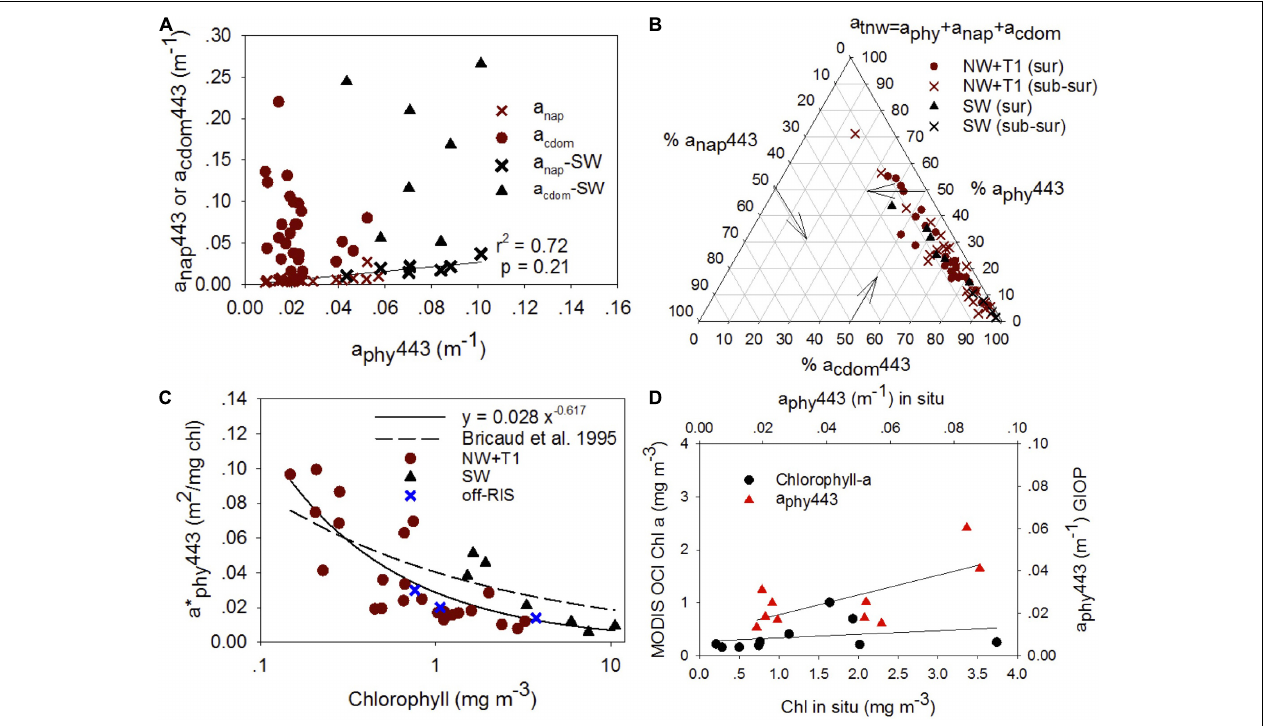
FIGURE 11 | Particulate matter relationships and satellite estimates. (A) a nap 443 and a g 443 vs a phy 443 for surface (0 – 20 m), (B) Ternary plot showing the relative contributions (percent) of phytoplankton absorption (a phy ), non-algal absorption (a nap ) and CDOM absorption (a cdom ) to total non-water absorption (a tnw = a phy + a nap + a cdom ) at 443 nm for surface (0 ∼ 20 m) and subsurface ( > ∼ 20 m) waters, (C) relation between chlorophyll and specific phytoplankton absorption at 443 nm (a* phy 443) for the SW and other regions of the shelf for surface waters (0 to ∼ 20 m). The regression fit for all the data are depicted. For comparison, the regression fit from Bricaud et al., 1995 study is shown (dashed line). (D) Comparison of in situ chlorophyll with standard NASA chlorophyll a algorithm (OCx) (black circles; y = 0.07 × + 0.27; r 2 = 0.07; p = –0.13) and in situ a phy 443 vs MODIS (red triangles; y = 0.37 × + 0.01; r 2 = 0.47; p = 0.05) using the generalized NASA semi-analytic algorithm